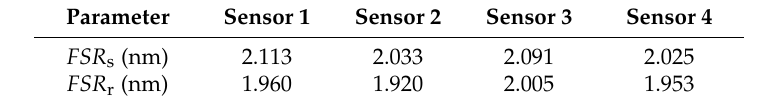
Table 1. Parameters of FSR of four sensors.